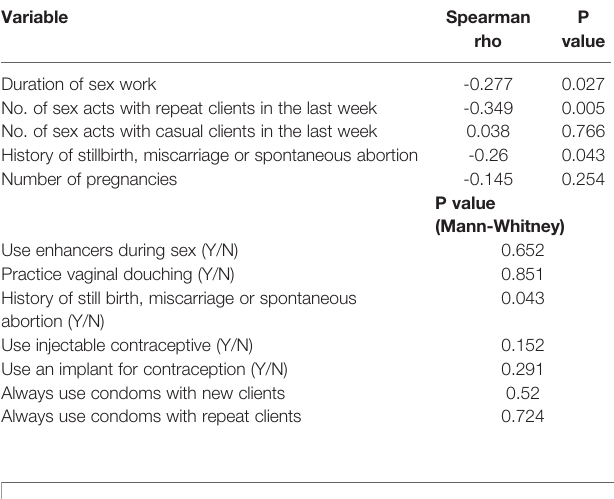
TABLE 2 | Correlation of cervicovaginal Tregs with sexual behavioral and reproductive